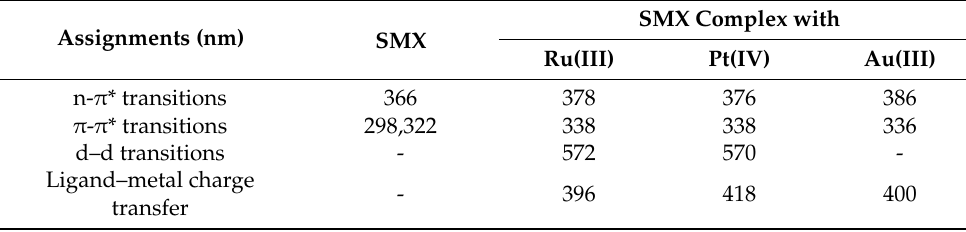
Table 4. UV-Vis. spectrum of sulfamethoxazole, Au(III), Pt(IV), Ru(III), and complexes. Assignments (nm) SMX n- π * transitions